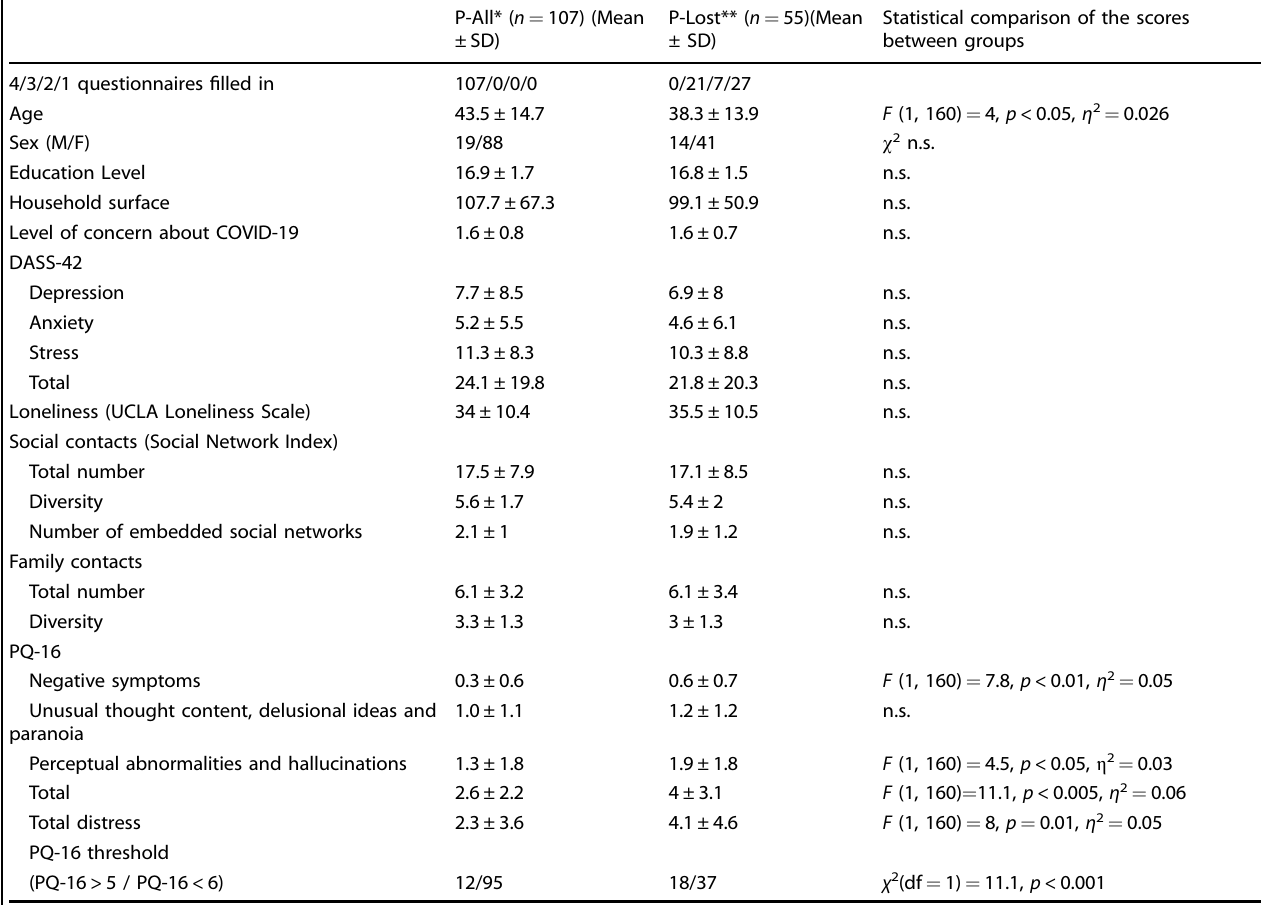
Table 2. Sociodemographic, psychosocial and psychological characteristics of those who participated at all time points (P-All) and those lost to follow-up (P-Lost) at